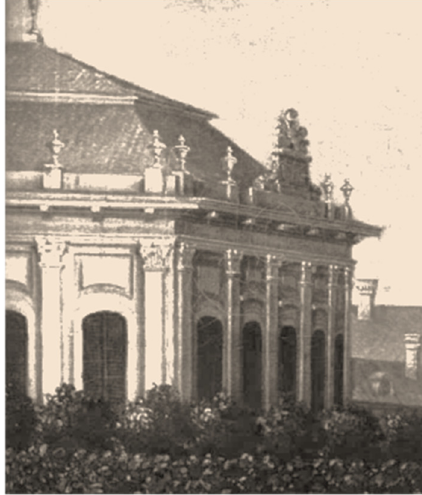
Figure 1. Drawing of the second Eszterháza Opera House. Enlarged detail of Antonio Pesci’s painting depicting the south facade of the palace–(Építészeti Múzeum—Museum of Architecture, Budapest).